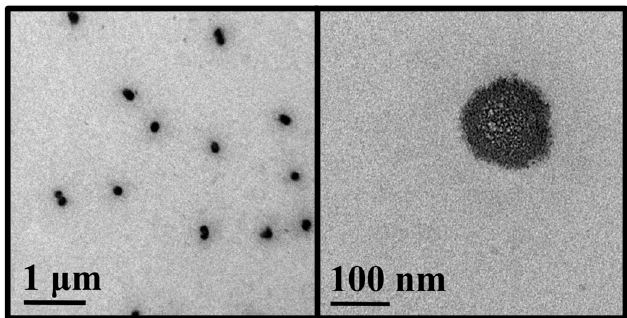
Figure 11. TEM images of PEG- b -CPCL-70:pDNA nanocomplexes at 200:1 mass ratio (N/P = 142). The low magnification TEM image ( left ) shows a narrow size distribution of nanosized nanocomplexes, and the high magnification TEM image ( right ) shows the nanostructural details of a nanocomplex.